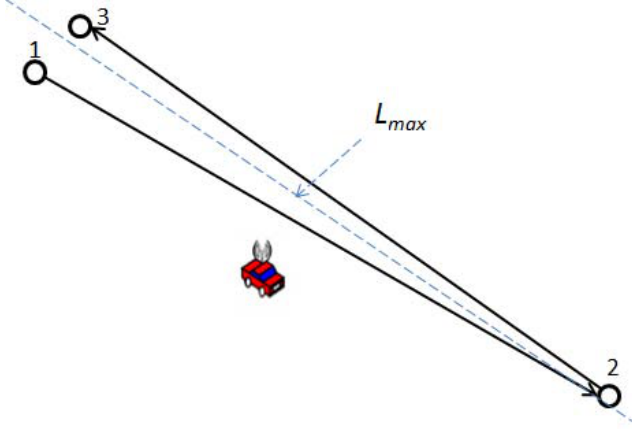
Figure 1. Situation where the MC must move the longest